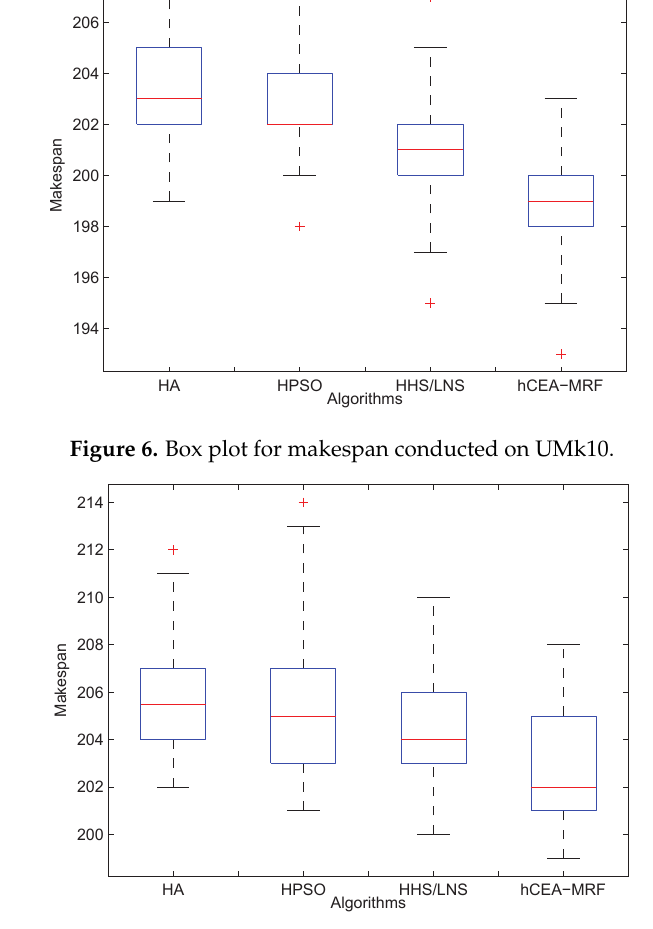
Figure 7. Box plot for makespan conducted on